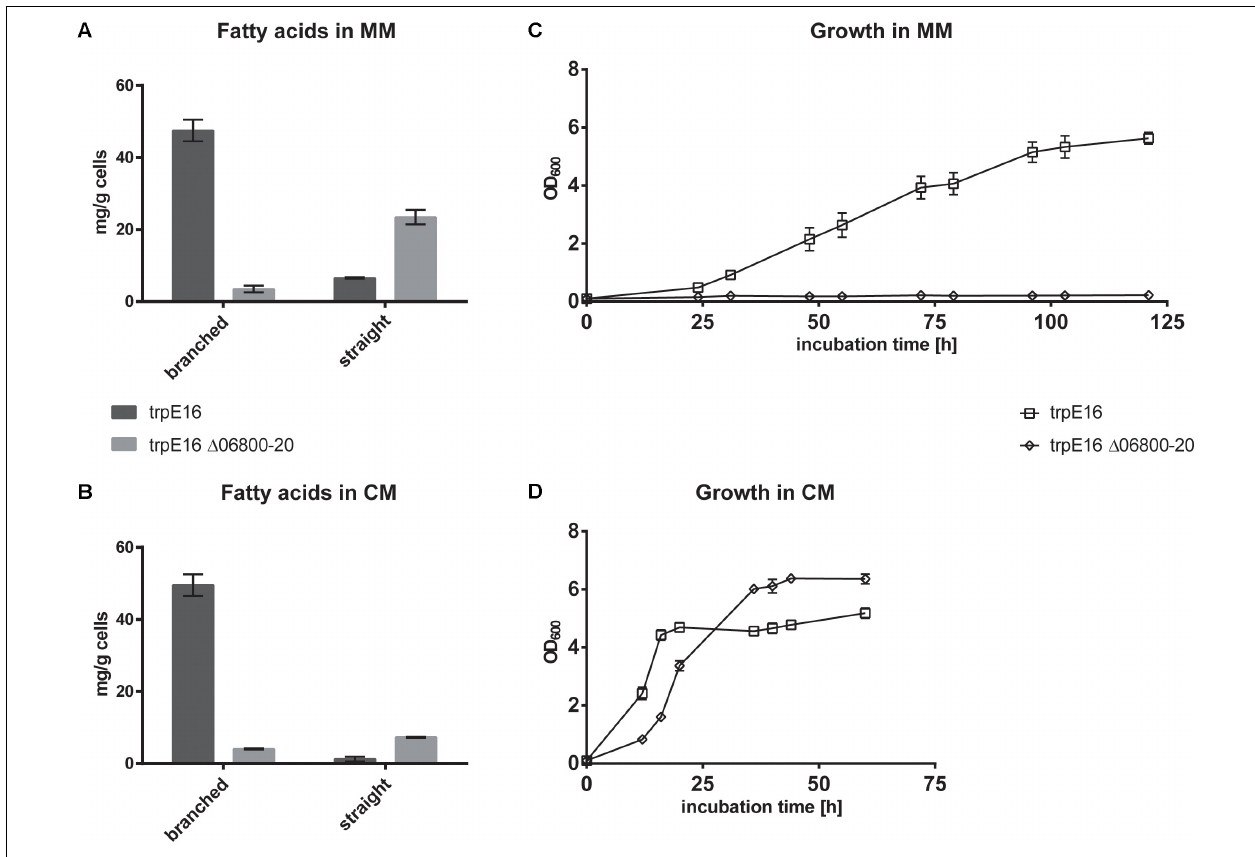
FIGURE 2 | Branched and straight chain fatty acid amounts in wild type M. luteus trpE16 and in the BCKD deletion mutant trpE16 (cid:49) 06800-20:hyg grown in minimal medium (MM) (A) and complex medium (CM) (B) . Each bar represents the data from two biological replicates. Growth curves of trpE16 and the BCKD deletion mutant in minimal medium (C) and in complex medium (D) . Each curve represents data from three biological replicates, error bars represent standard